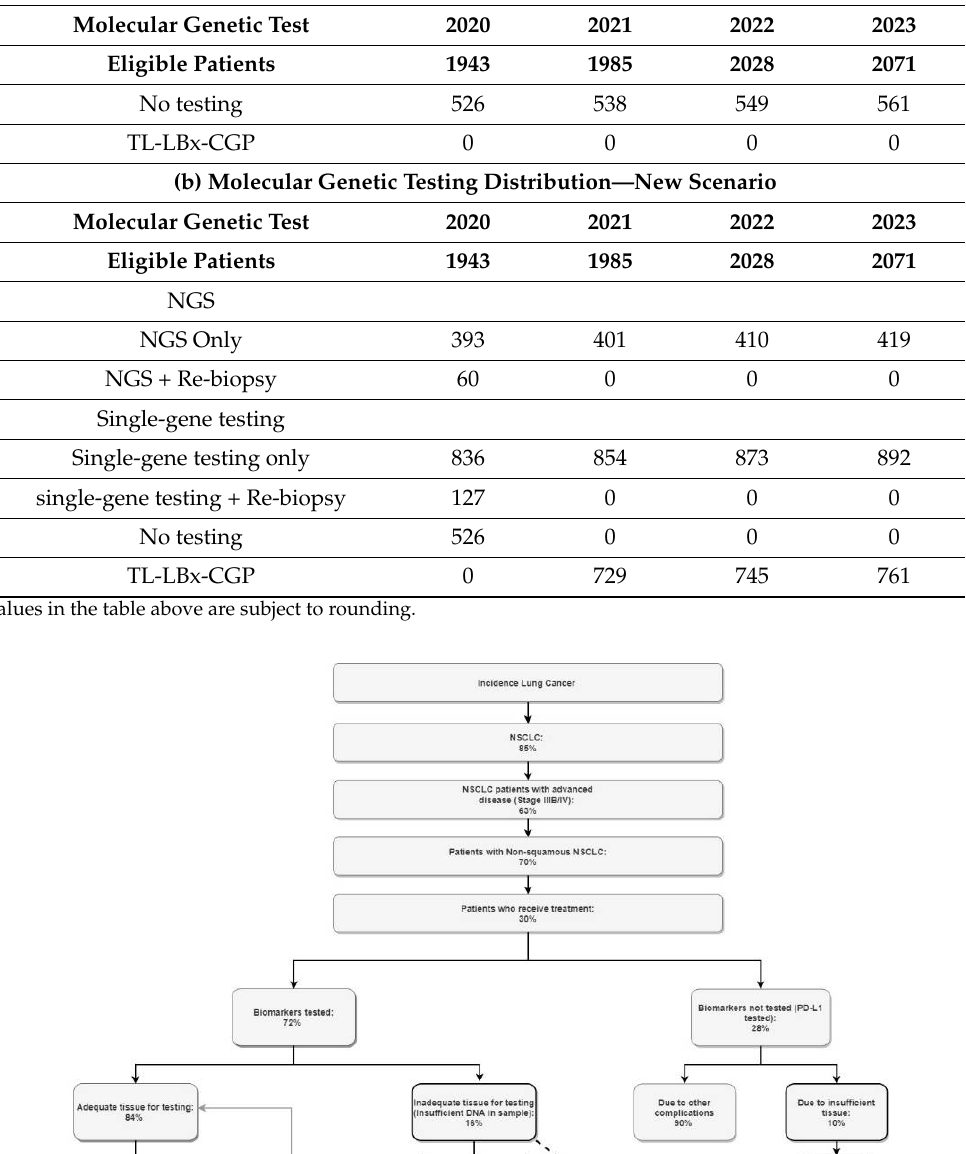
(a) Molecular Genetic Testing Distribution—Reference Scenario